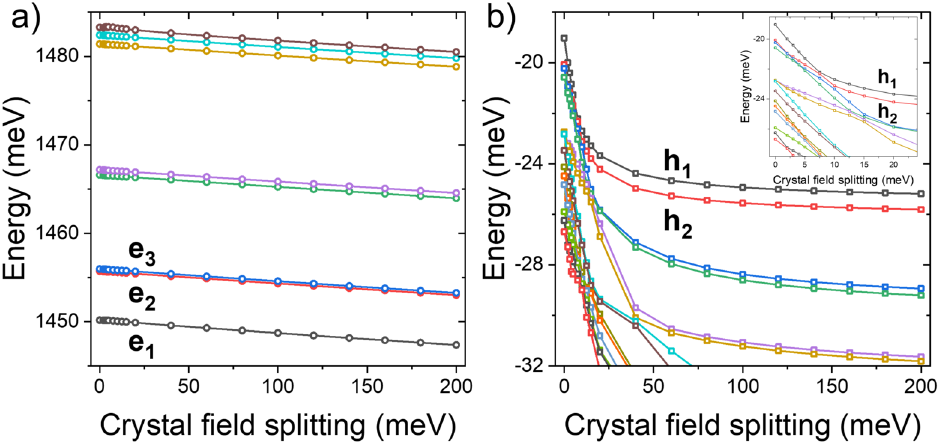
Figure 5. The effect of WZ crystal field splitting on the spectra of electron ( a ) and holes ( b ). Whereas the electron shows a relatively negligible drift under the inclusion of WZ crystal field splitting, the detailed structure of the hole state changes dramatically, especially if compared to a case with a crystal field neglected (see the